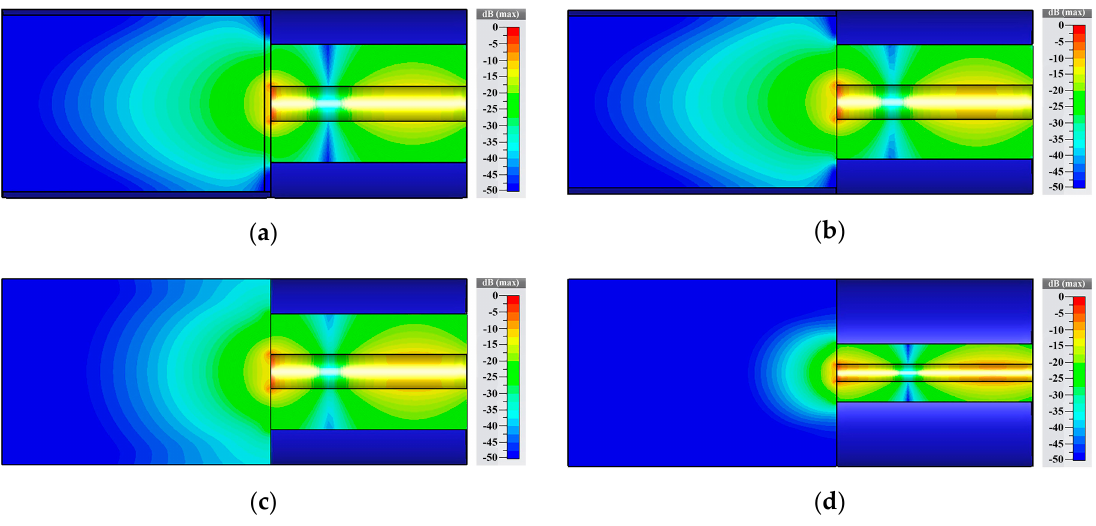
Figure 4. Simulated and measured results of S-parameter of the proposed sensor with isolation layer and without isolation layer.